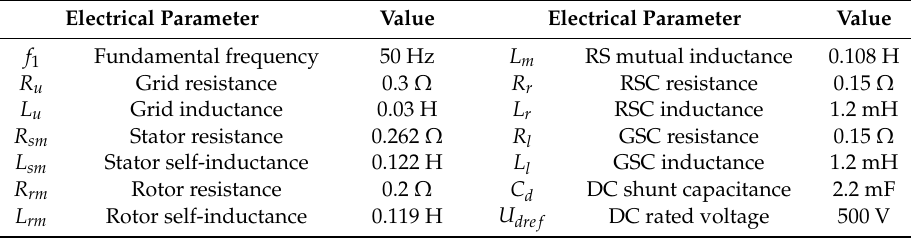
Table 1. The electrical parameters of the DFIG-based system.